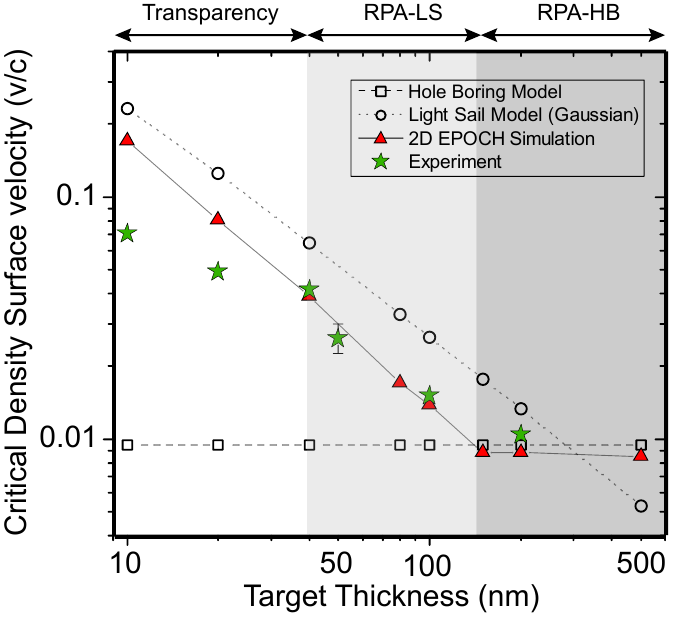
Figure 6. Comparison of experiment and simulation results, and HB and LS model calculations, for the maximum PCDS velocity (on a logarithmic scale) as a function of target thickness. Three distinct regimes: HB-dominant; LS-dominant; and RSIT-onset; are identified, as delineated by the background